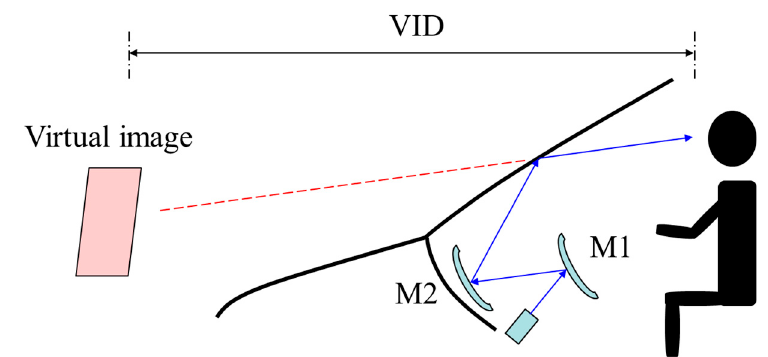
Figure 14. A schematic of a HUD system.